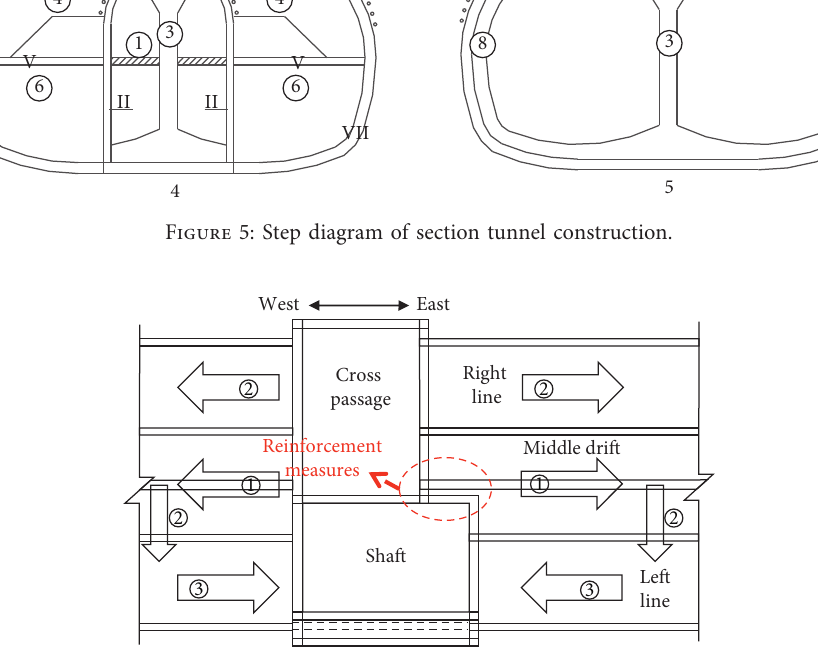
Figure 6: Plane position and construction diagram of shaft cross passage and section